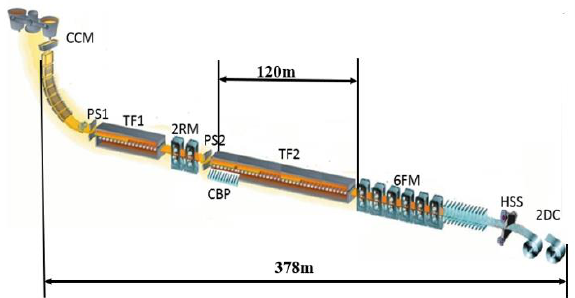
Figure 1. The layout of Tangshan Donghua DSCCR production line.